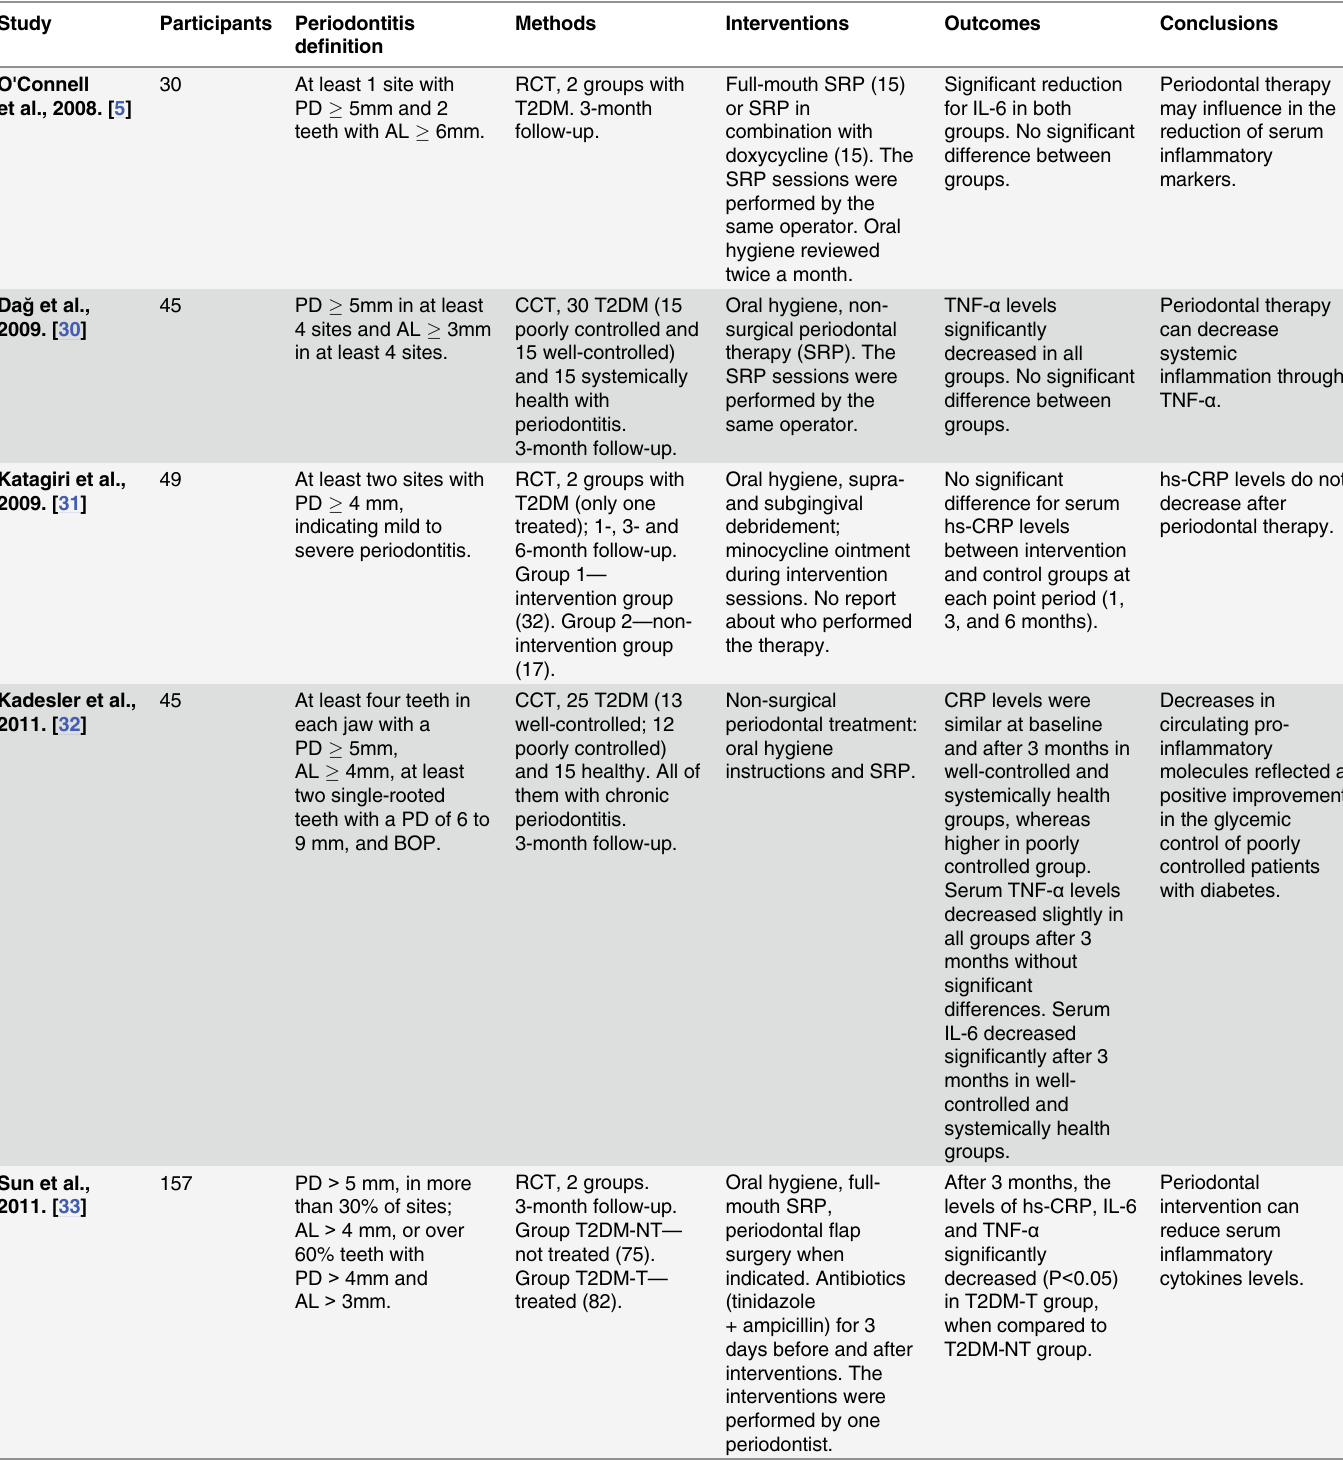
Table 1. Characteristics of included